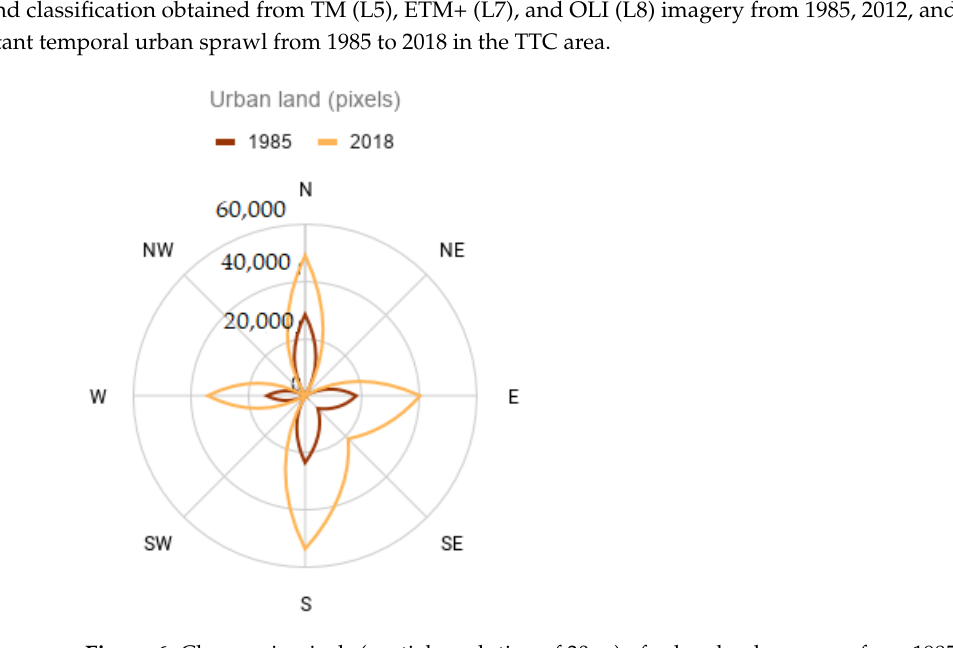
Figure 6. Changes in pixels (spatial resolution of 30 m) of urban land coverage from 1985 to 2018 for each of the five sectors (N, E, SE, S, and W) in the TTC area in 1985 and 2018.